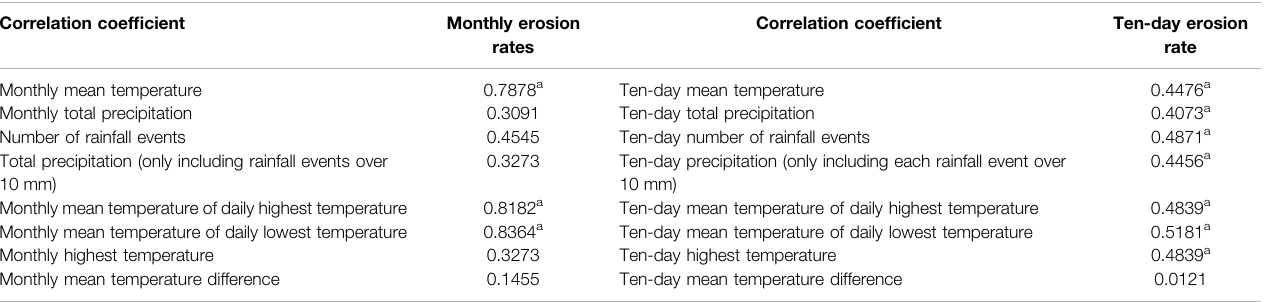
TABLE 1 | Nonlinear correlations for Monthly and Ten-day erosion rates and environmental